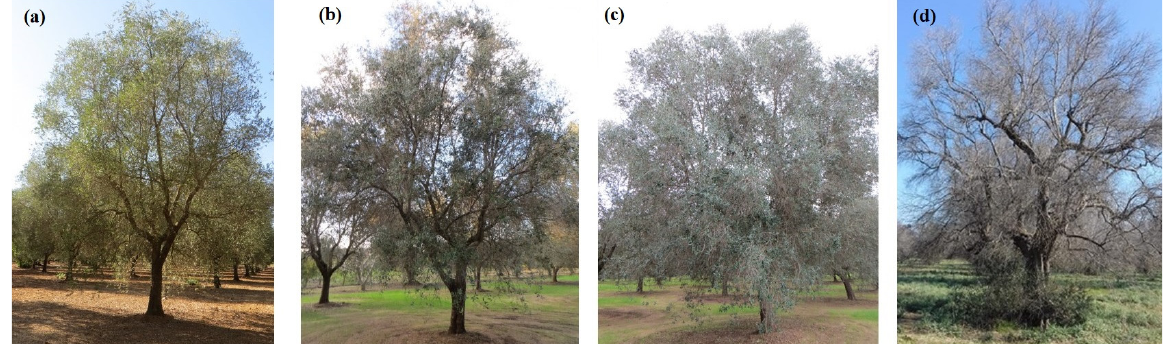
Figure 8. Temporal evolution of an olive tree classified as infected on 22 September 2017 ( a ) on the following three dates: 30 March (2018) ( b ); 16 November 2018 ( c ); 8 August 2019 ( d ).